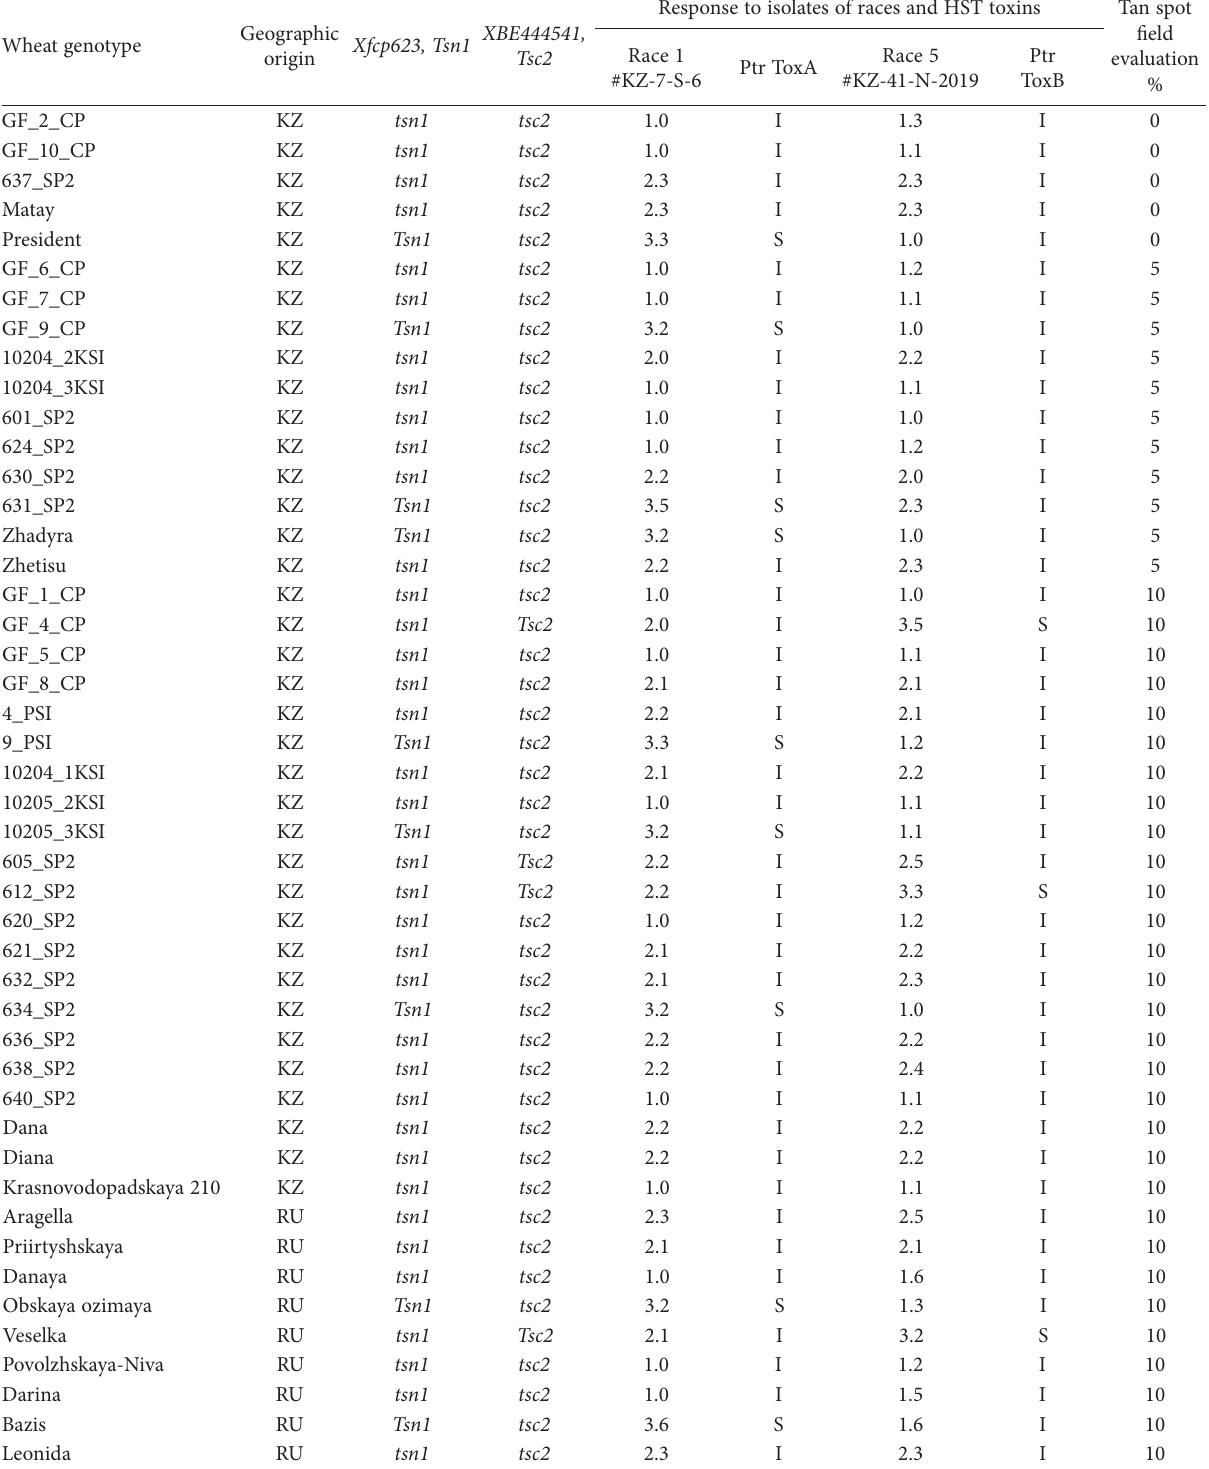
Table 3. Reactions of wheat genotypes to Pyrenophora tritici-repentis races 1 and 5, and the toxins ToxA and ToxB, in molecular screening and field